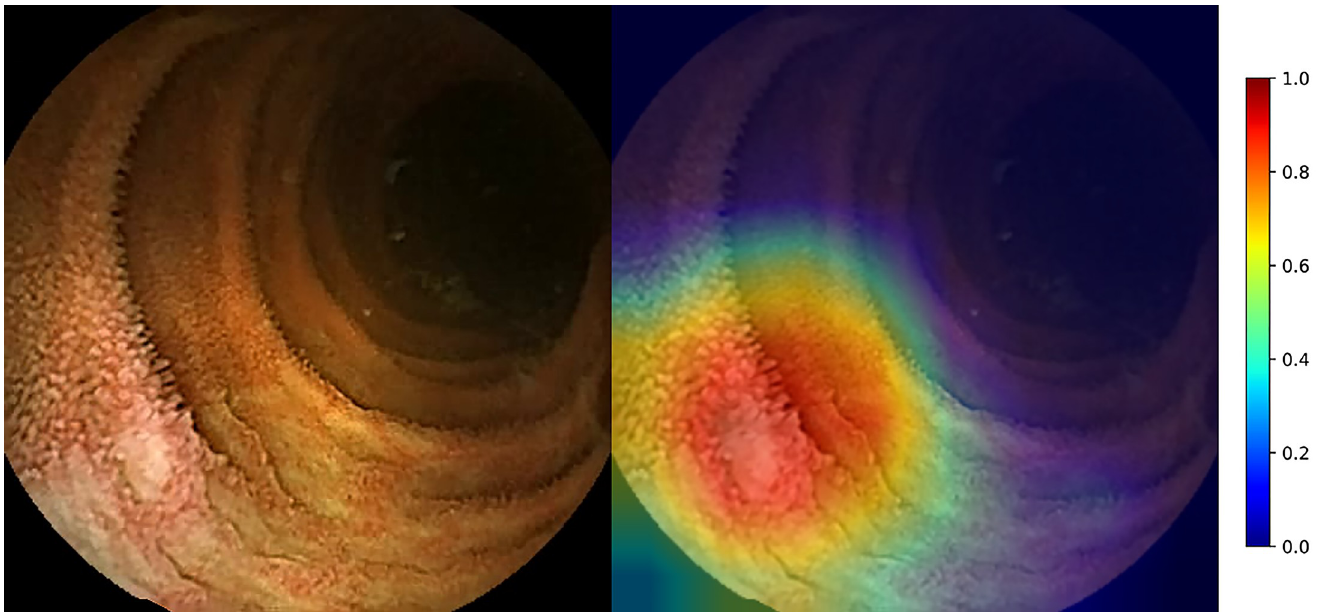
Fig 2. Class activation map of inflamed mucosa. Jet color map showing the normalized prediction where reddish and bluish colors are close to 1 and 0, respectively (right bar). An ulcer in the left, lower corner of the image is highlighted in red. This figure demonstrates the approximate mechanism of AI.